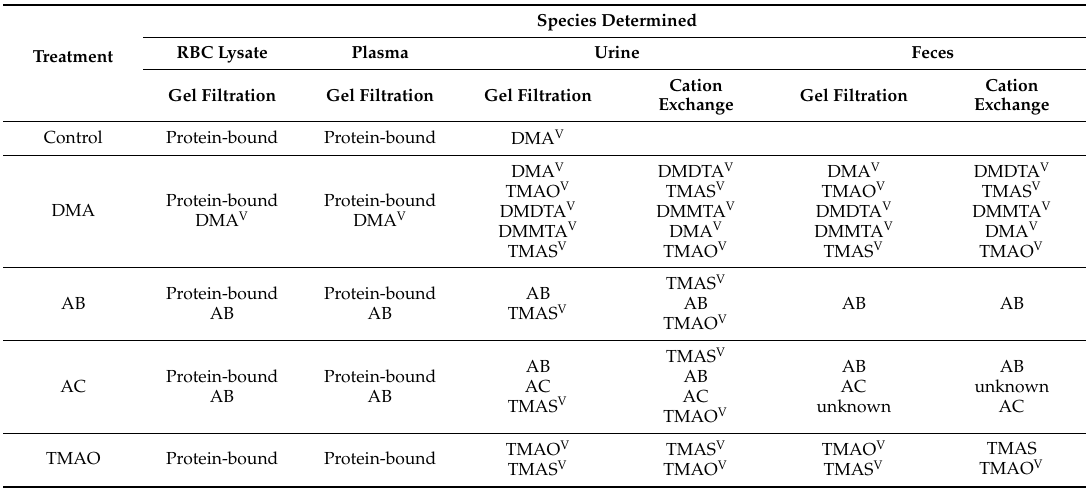
Table 2. Arsenical species in biological